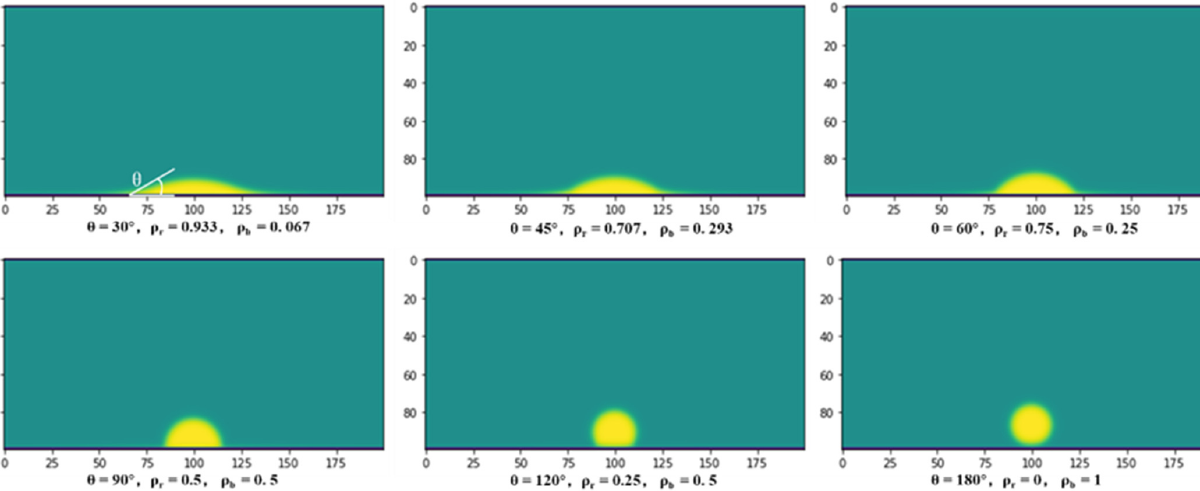
Figure 6. Static contact angles with different values of two-phase density on the solid boundary. Then, considering different wetting angles and different two-phase viscosity ratios (